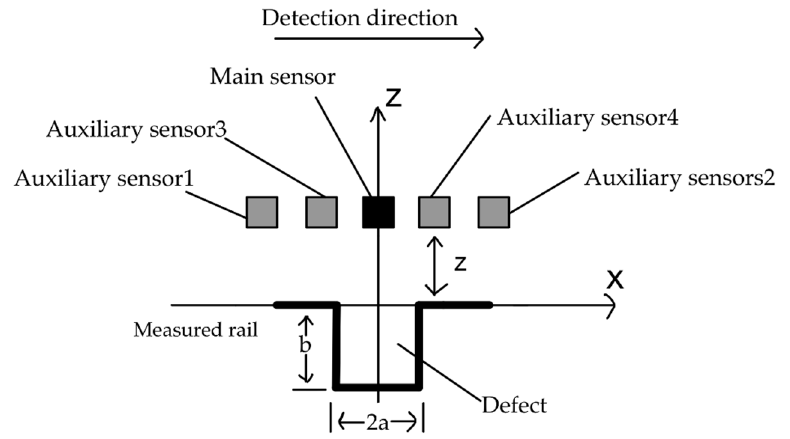
Figure 2. The x - z plane near a defect.